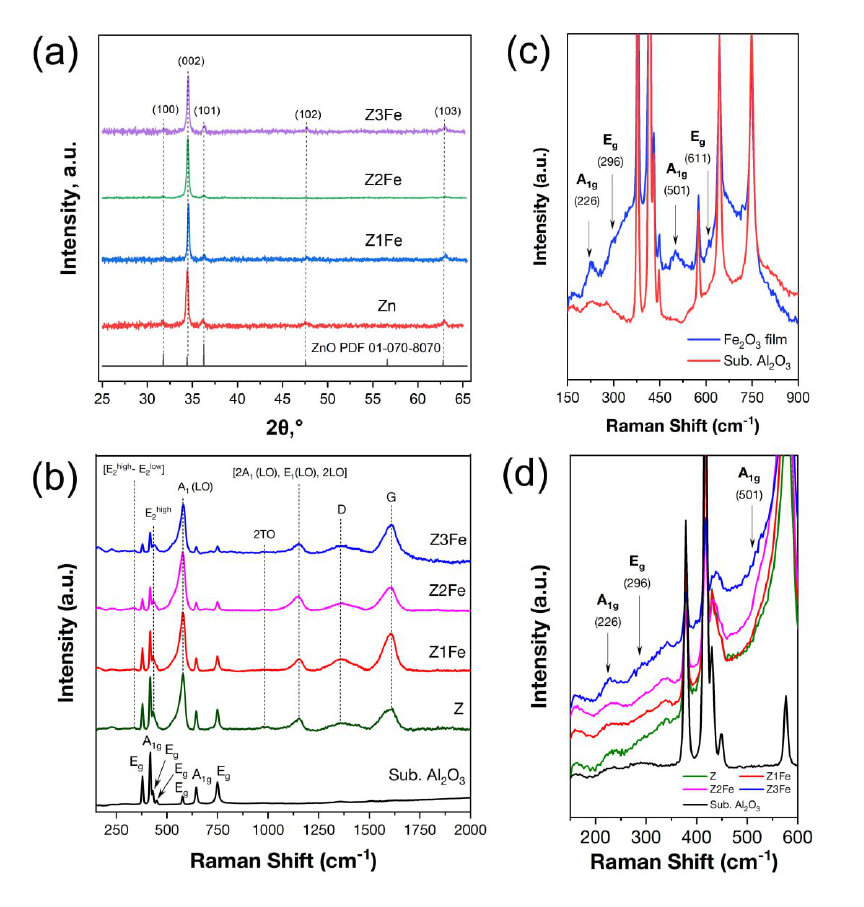
Figure 3. XRD-pattern for ZnO/Fe 2 O 3 films on glass substrate ( a ) and Raman spectra for ZnO/Fe 2 O 3 thin films on Al 2 O 3 ( b ); enlarged Raman spectra of individual Fe 2 O 3 ( c ) and ZnO/Fe 2 O 3 films on Al 2 O 3 substrate ( d